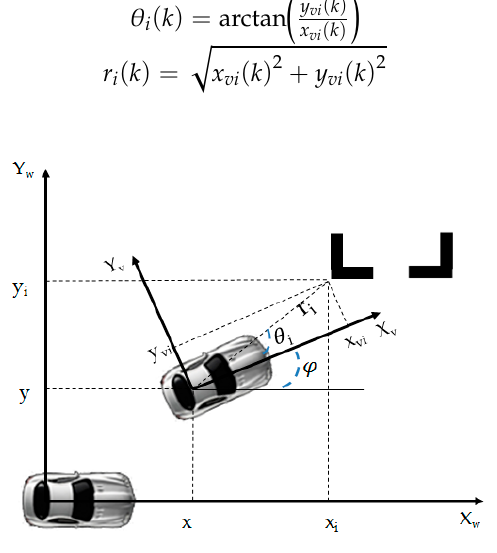
Figure 6. CS and parameter definition.